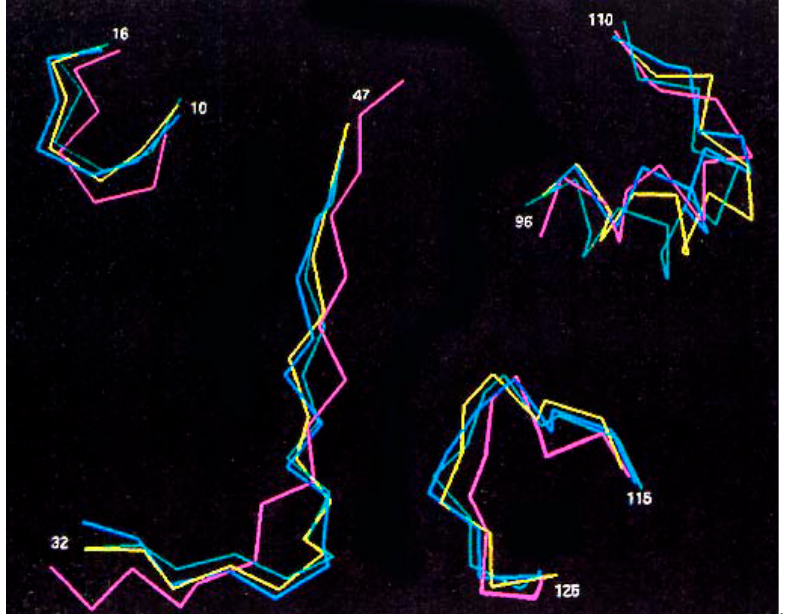
Figure 2. C α traces for effector domains of molecular dynamics average structures of different forms of RAS-p21. Color scheme is: pink, wild-type RAS-p21-GDP; yellow, RAS-p21-GTP; blue, G12V-RAS-p21-GTP; green, Q61L-RAS-p21-GTP. The residue numbers for each domain are shown in the figure